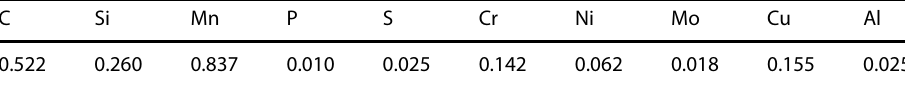
Table 1 Chemical composition of the material (wt. % and Fe balance)